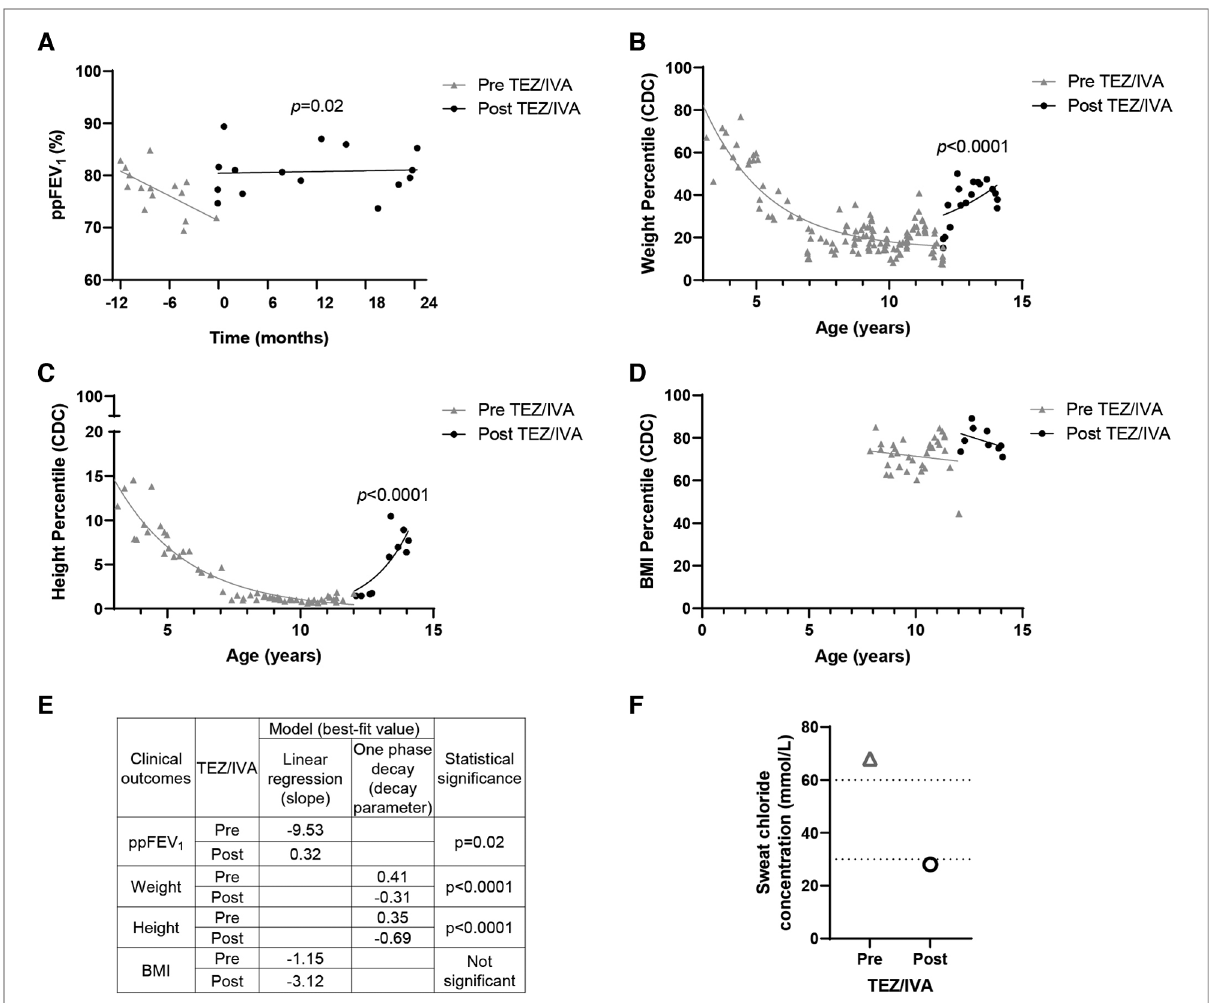
FIGURE 1 Effect of TEZ/IVA in vivo on lung function, nutritional factors and sweat chloride concentration in a patient with S945L/G542X-CFTR. ( A ) Lung function (ppFEV 1 ) 12 months pre and 24 months post initiation of TEZ/IVA treatment. Serial ( B ) weight, ( C ) height and ( D ) body mass index (BMI) measurement percentiles from three years of age until 24 months post initiation of TEZ/IVA. Percentiles are based on data from the Centers for Disease Control and Prevention (CDC) growth charts. ( E ) Table summarizing statistical models applied to clinical outcome measurements and the best- fi t values pre and post initiation of TEZ/IVA treatment. A simple linear regression was fi t to the ppFEV 1 ( A ) and BMI percentile ( D ) measurements from the time periods pre TEZ/IVA (grey line) and post TEZ/IVA (black line). The slope for each time period was estimated and the difference between them was tested. A one phase decay model was fi t to the weight ( B ) and height ( C ) percentile measurements from the time periods pre TEZ/IVA (grey line) and post TEZ/IVA (black line), with zero as a shared plateau value and separate intercept values. The decay parameter for each time period was estimated and the difference between them was tested. ( F ) Sweat chloride concentration (mmol/L) measurements taken at baseline and 24 months post initiation of TEZ/IVA treatment. Dotted lines indicate lower limits of CF diagnostic (>60 mmol/L) and CF indeterminate (30 – 59 mmol/L) value ranges. No statistical modelling for sweat chloride concentration was performed due to single measurements pre and post